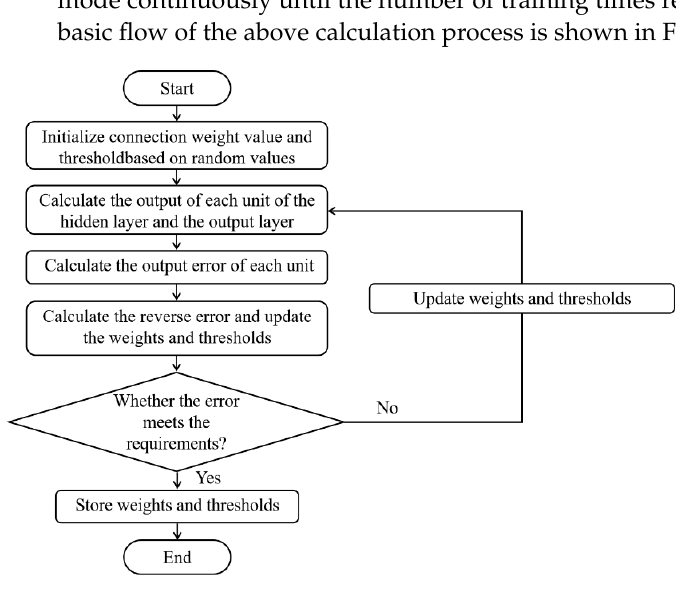
Figure 5. The calculation process chart for the fully-connected ANN model.